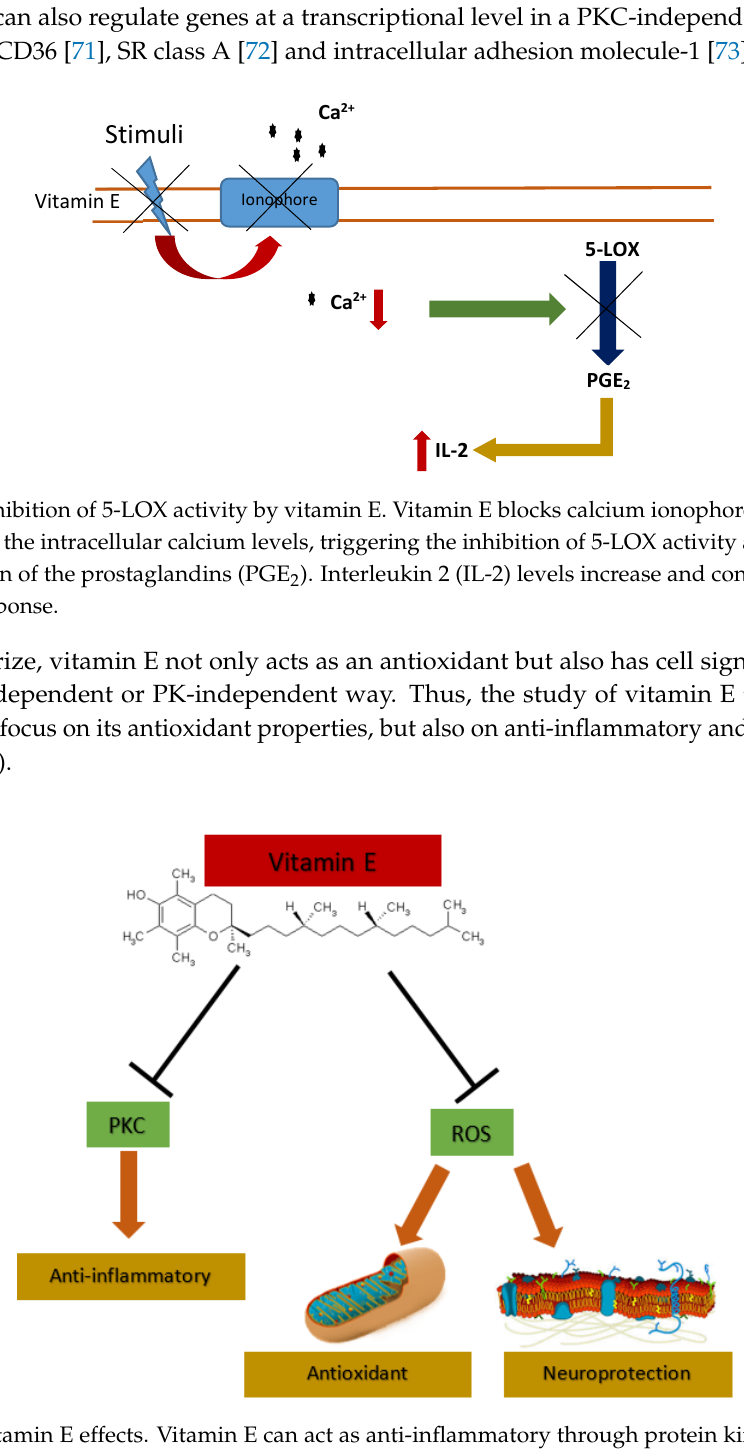
Figure 2. Vitamin E effects. Vitamin E can act as anti-inflammatory through protein kinase C (PKC) inhibition and has antioxidant and neuroprotection properties through the attack to reactive oxygen species